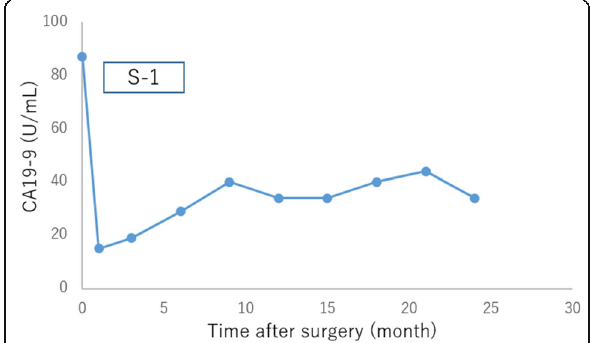
Fig. 7 Changes in serum carbohydrate antigen 19 – 9 (CA19-9) level associated with postoperative chemotherapy in case 2. CA19-9 level of postoperative month 0 shown in the graph indicates the pre- operative CA19-9 level